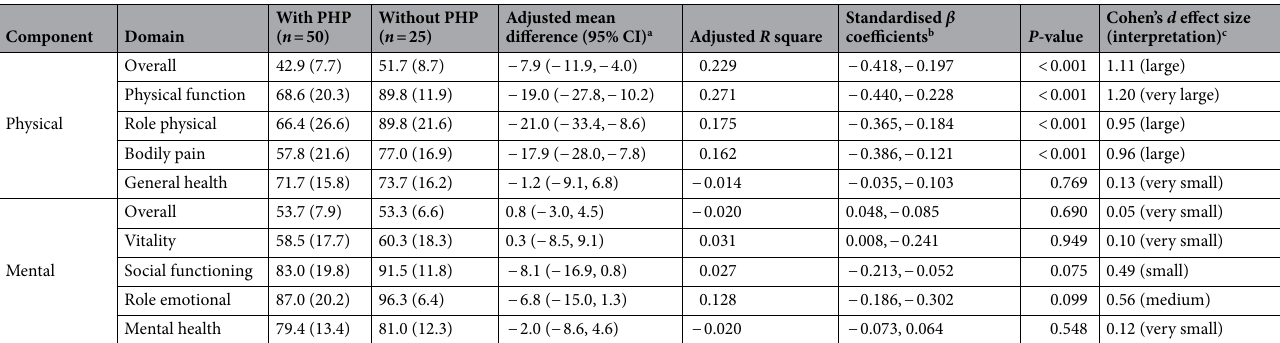
Table 3. Comparison of generic health-related quality of life as measured with the SF-36 in participants with and without PHP—values are means (SDs). Scores for the SF-36 range from 0 to 100 with lower scores indicating poorer health status and higher scores indicating better health status for an individual. a Mean difference adjusted for the covariate osteoarthritis. b Two standardised β coefficients are provided—the first for group (i.e. with or without PHP) and the second for the covariate (i.e. comorbidity) osteoarthritis. c Interpretations for the Cohen’s d effect sizes were taken from Sawilowsky 49 .